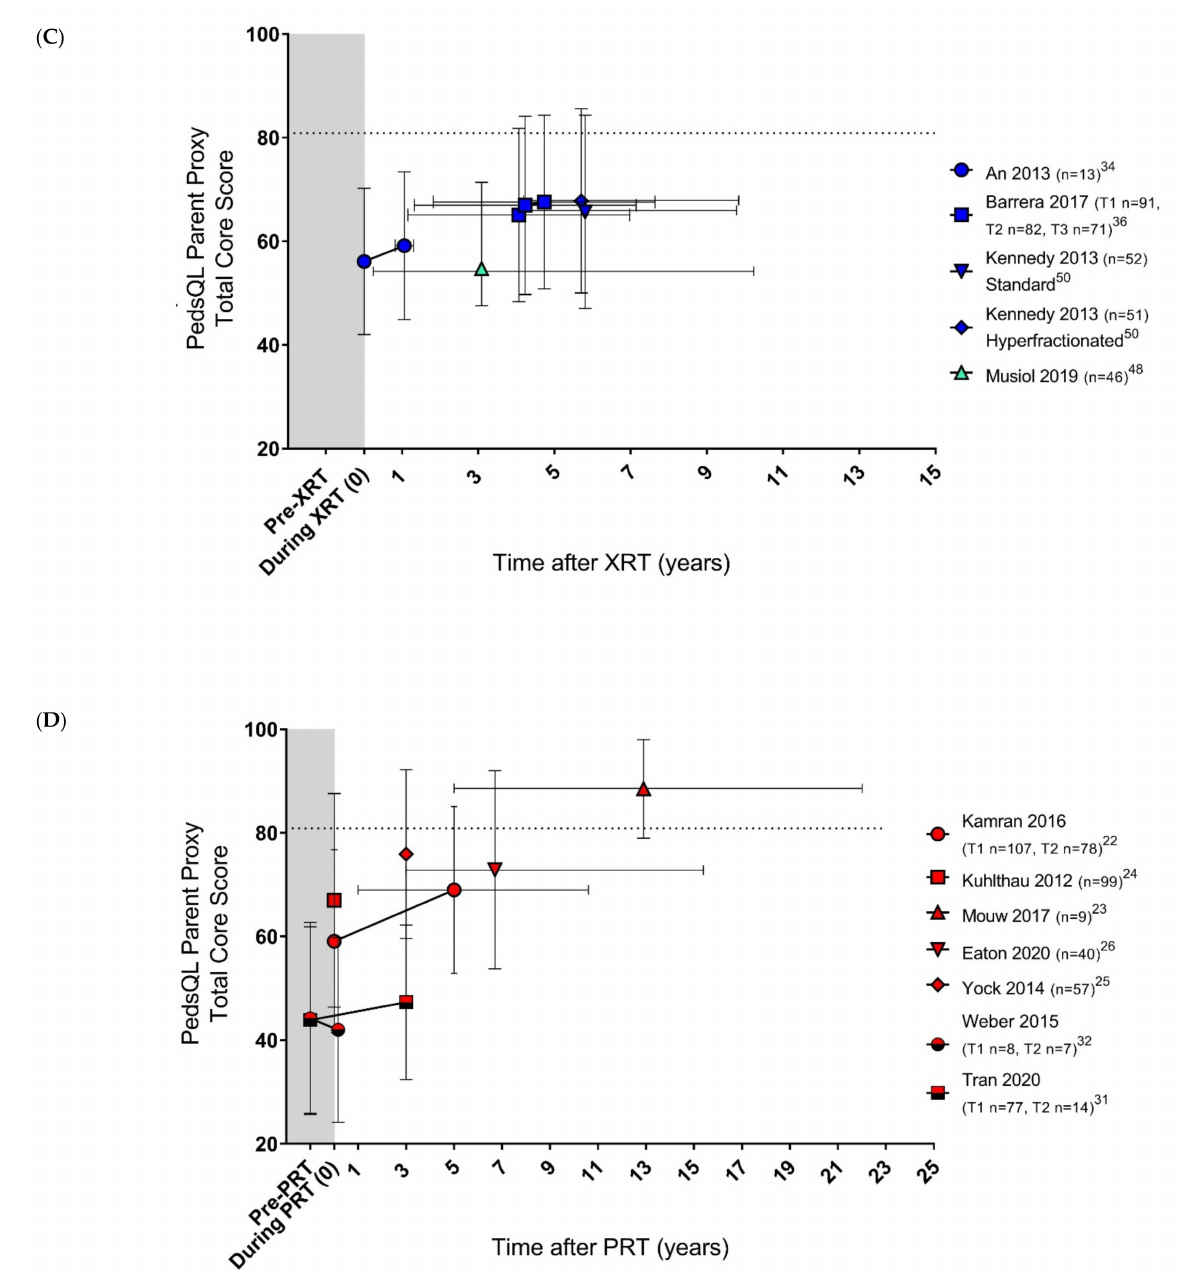
Figure 2. Health-related quality of life following photon ( A , C ) [34,36,40,42,47,48,50] and proton ( B , D ) [22–26,31,32] radiation therapy in paediatric central nervous system cancer, measured by PedsQL Generic Core self-report ( A , B ) and parent–proxy report ( C , D ). Legend. Blue: treated with photon radiation therapy. Mean and standard deviation (SD). Green: treated with photon radiation therapy. Median and inter-quartile ranges (IQR). Red: treated with proton radiation therapy. Mean and SD. The grey shading denotes assessment before or during treatment. Patients assessed during radiation therapy are placed at timepoint 0. Patients assessed prior to commencement of radiation therapy are placed at a combined timepoint before timepoint 0, due to each patient having a different duration from diagnosis to radiation therapy. Vertical lines represent SD or IQR. Horizontal lines denote duration of follow-up. The horizontal dashed line represents the mean healthy population PedsQL data from [52]. Higher PedsQL total core score indicates higher quality of life. Additional clarification on data was sought from [31]. Abbreviations: XRT, photon radiation therapy; PRT, proton radiation therapy; T,